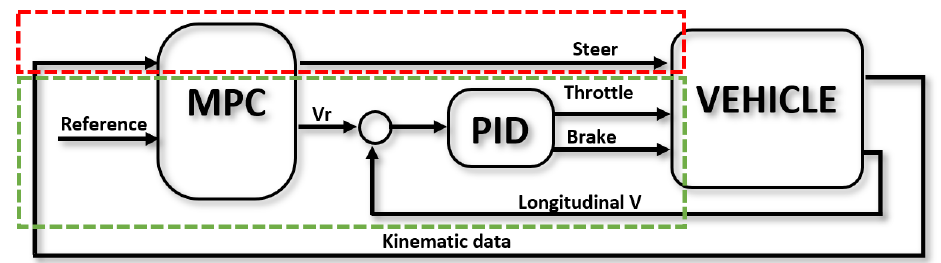
Figure 11. Control for parking. The MPC controller handles both lateral (red) and longitudinal control